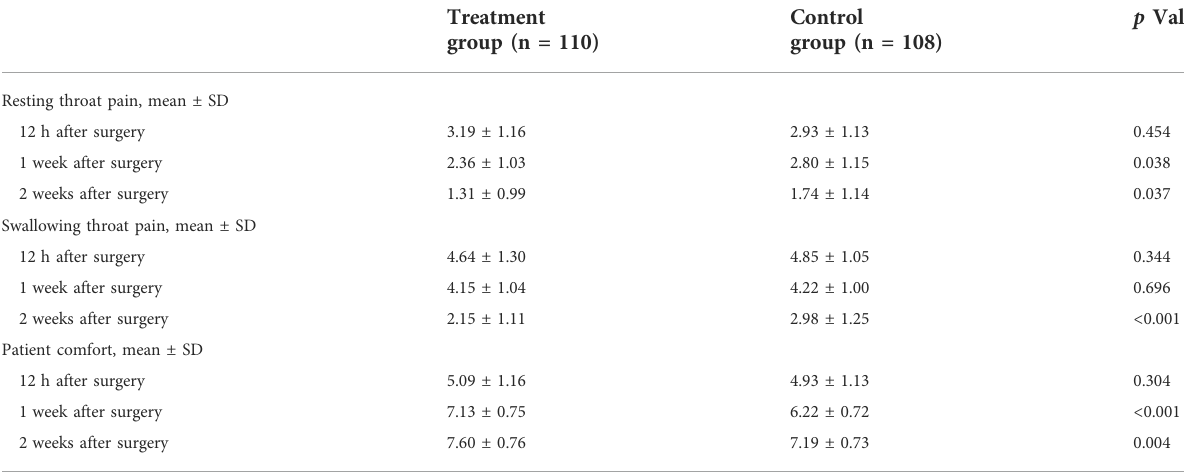
TABLE 2 The VAS score of postoperative pain and patient